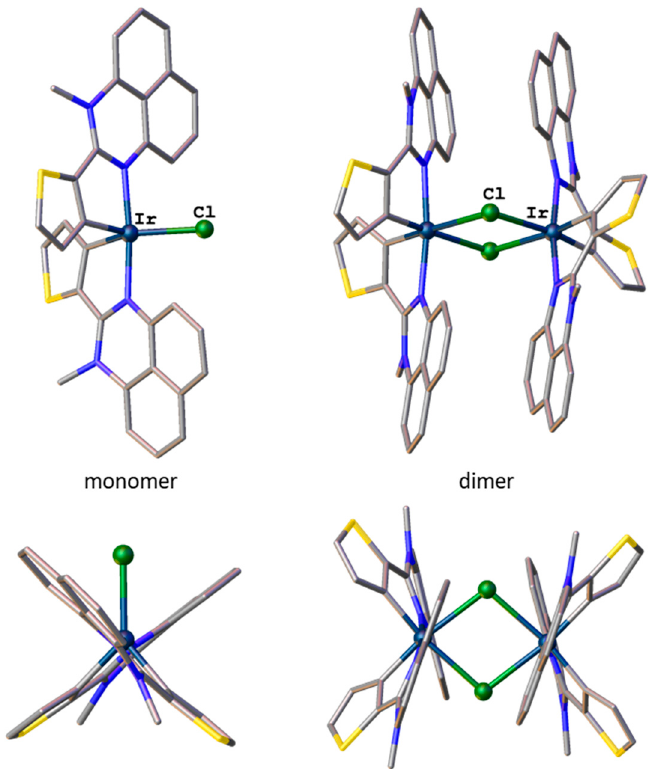
Figure 5. Optimized geometries of cyclometalated iridium(III) complexes with the perimidine L2 (gas-phase DFT calculations). From left to right: trigonal–bipyramidal monomeric chloride, octahe- dral μ -chloro-bridged dimer (two views are presented, hydrogen atoms are omitted for clarity).